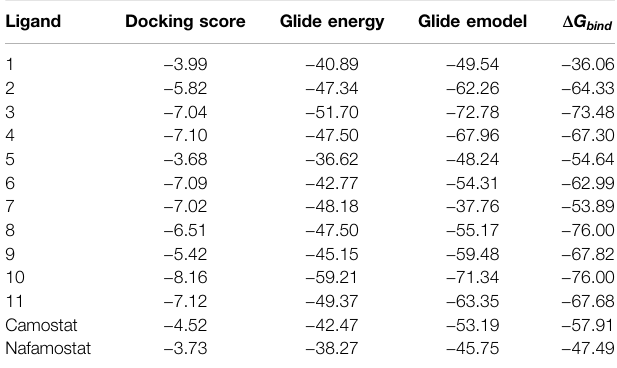
TABLE 4 | Glide Docking score, Glide energy, Glide emodel, and estimated free energy of binding for the best poses of investigated compounds in kcal/mol. Ligand